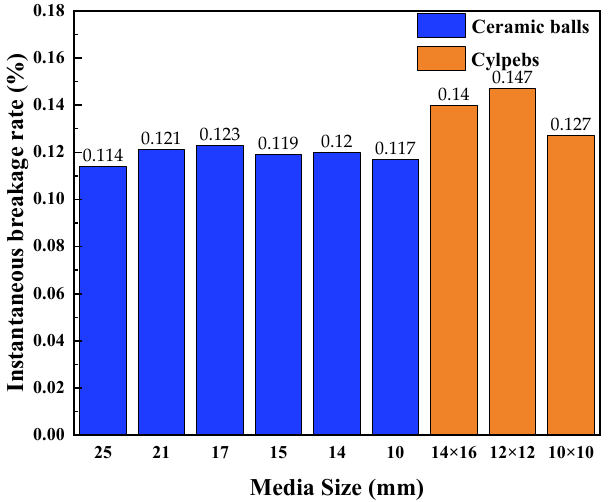
Figure 5. Instantaneous breakage rates of the grinding media at the same charge volume.